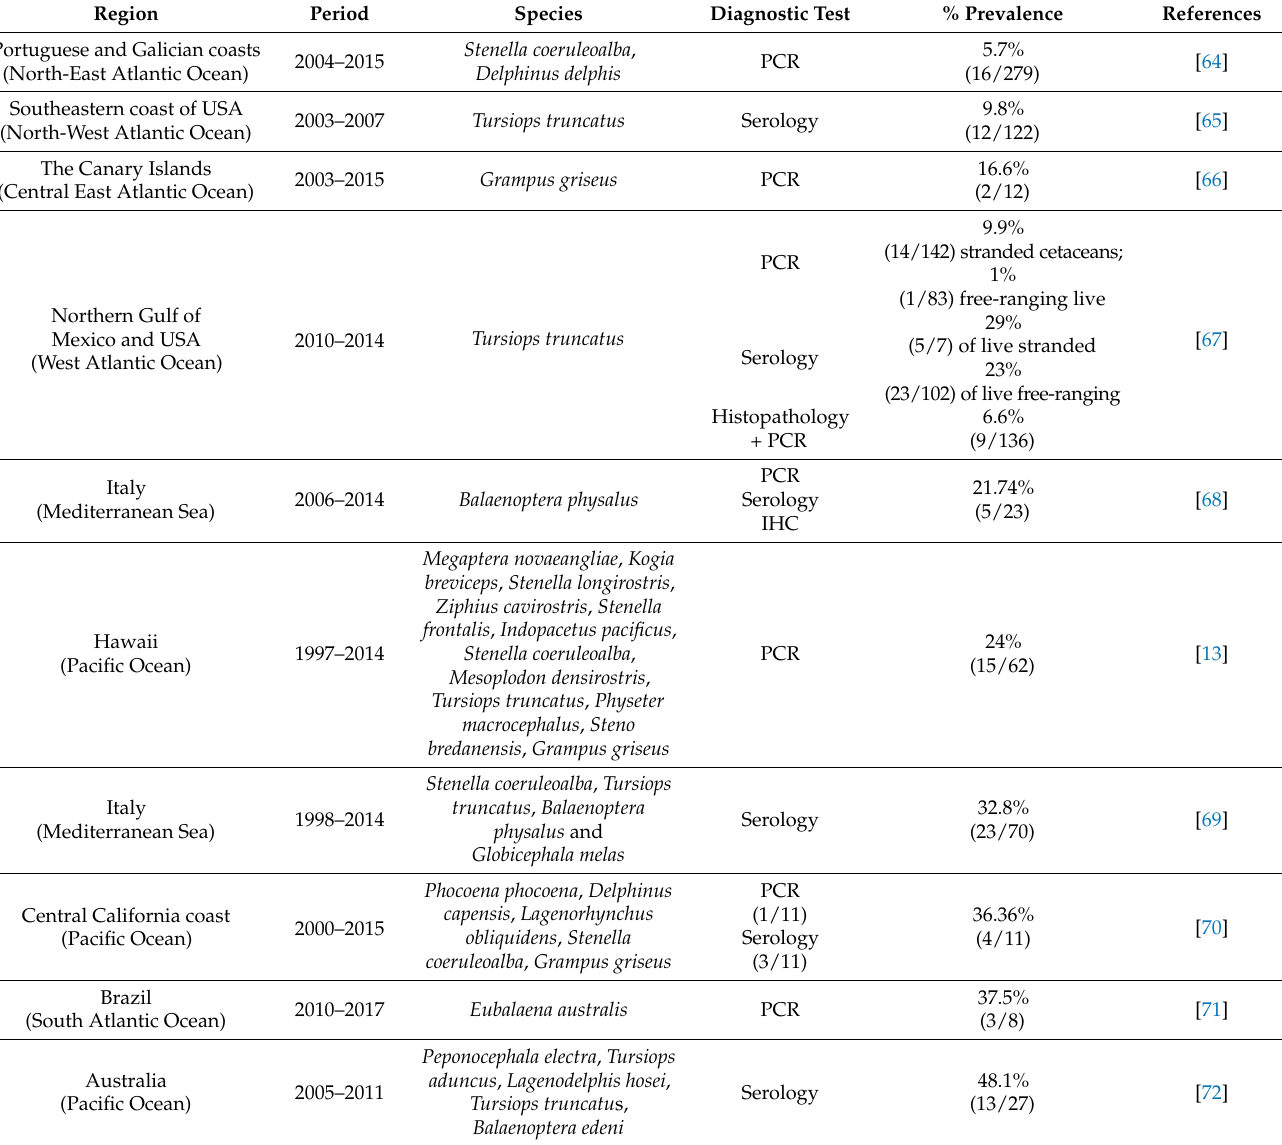
Table 2. Summary of the percentages of cetacean morbillivirus prevalences reported in other species, geographical zones and